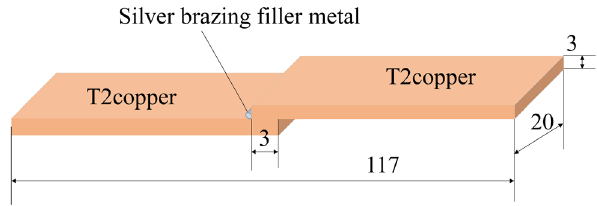
Figure 2: Schematic of the lap joint of a brazed joint ( mm ) .